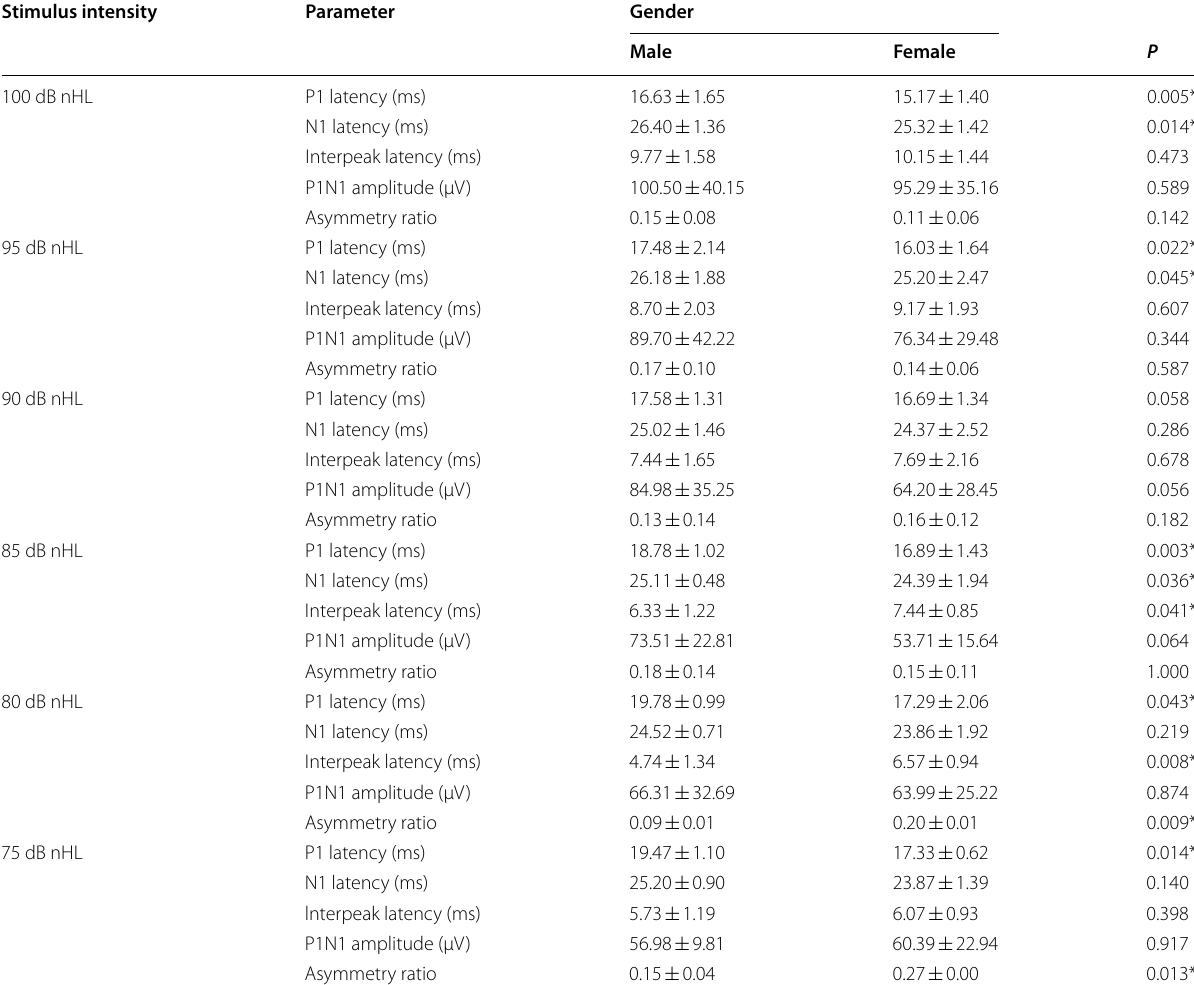
Table 2 Comparison of mVEMP measurement parameters by gender Stimulus intensity